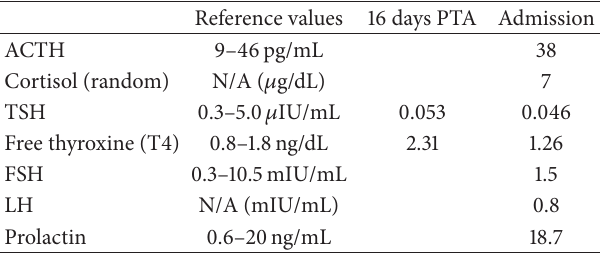
Table 1: Laboratory